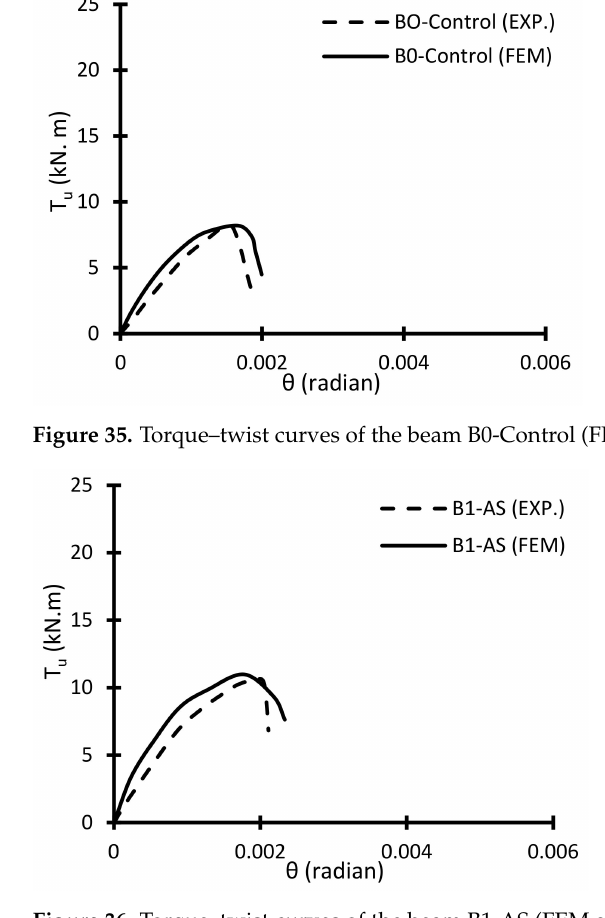
Figure 36. Torque–twist curves of the beam B1-AS (FEM and